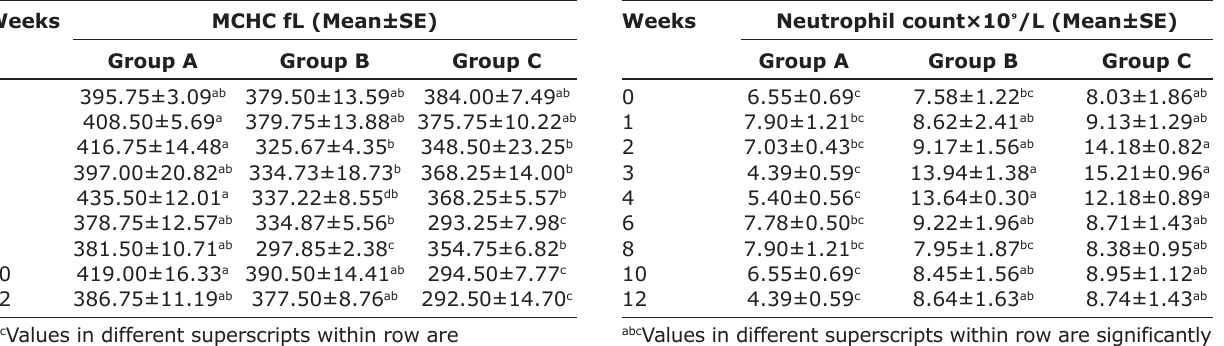
Table-5: MCHC in female goat’s postinoculation with C. pseudotuberculosis and MA. Weeks